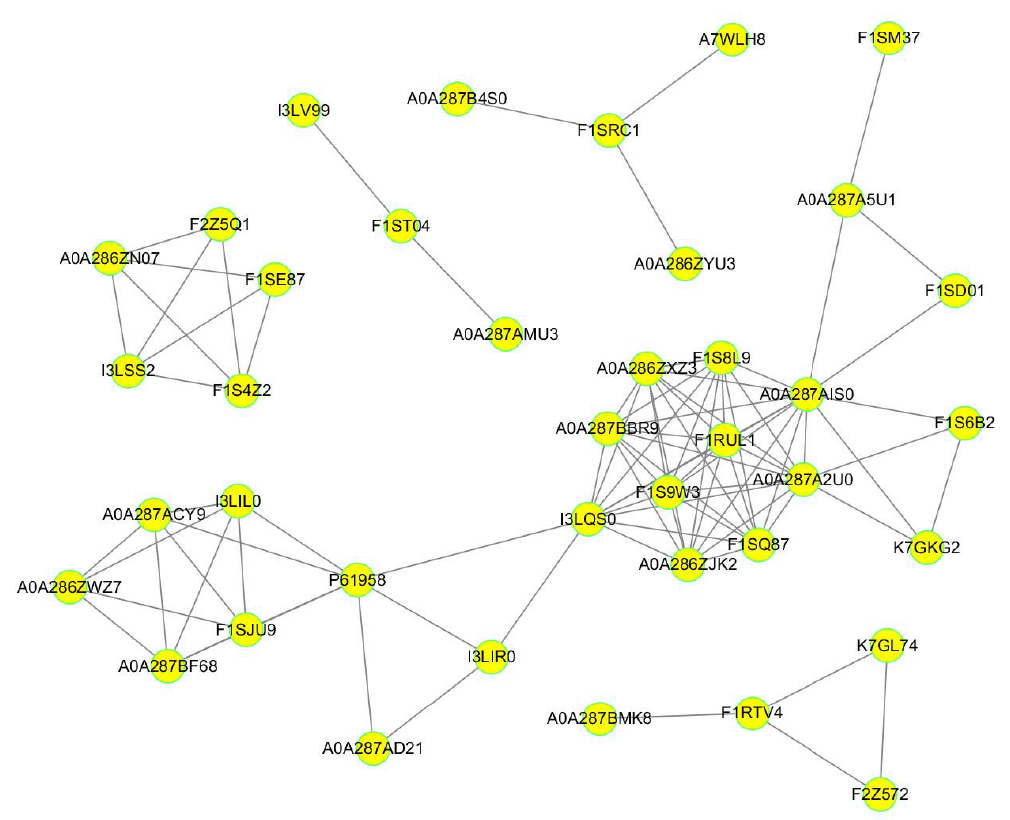
Figure 5. Protein-protein interaction networks were constructed based on the DEPs. The yellow nodes indicate the DEPs, and the lines are protein-protein interactions.